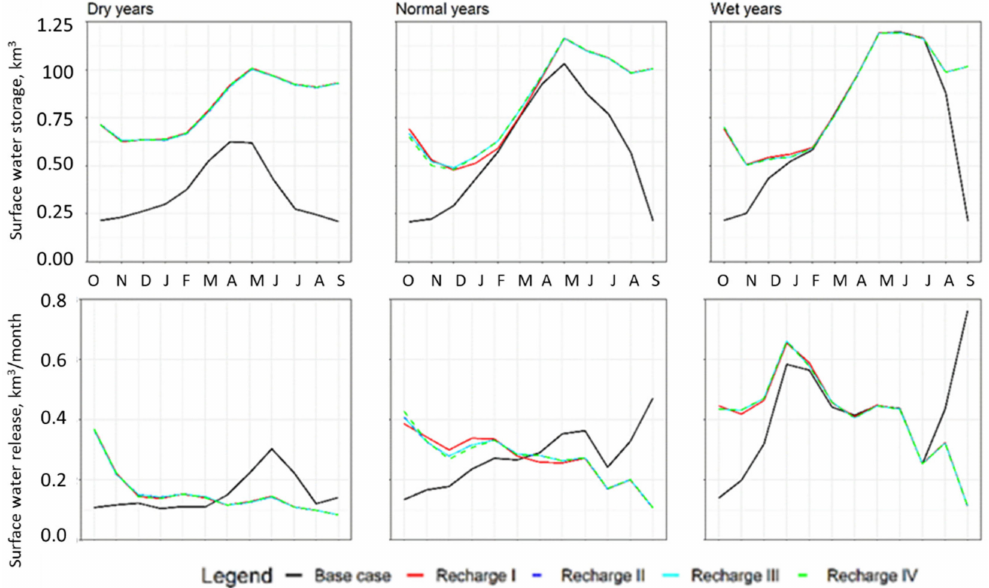
Figure 3. The monthly average storage behind the Folsom Dam ( top ) and average monthly release from the dam towards the hydropower facility ( bottom ) under three recharge scenarios in dry, normal, and wet